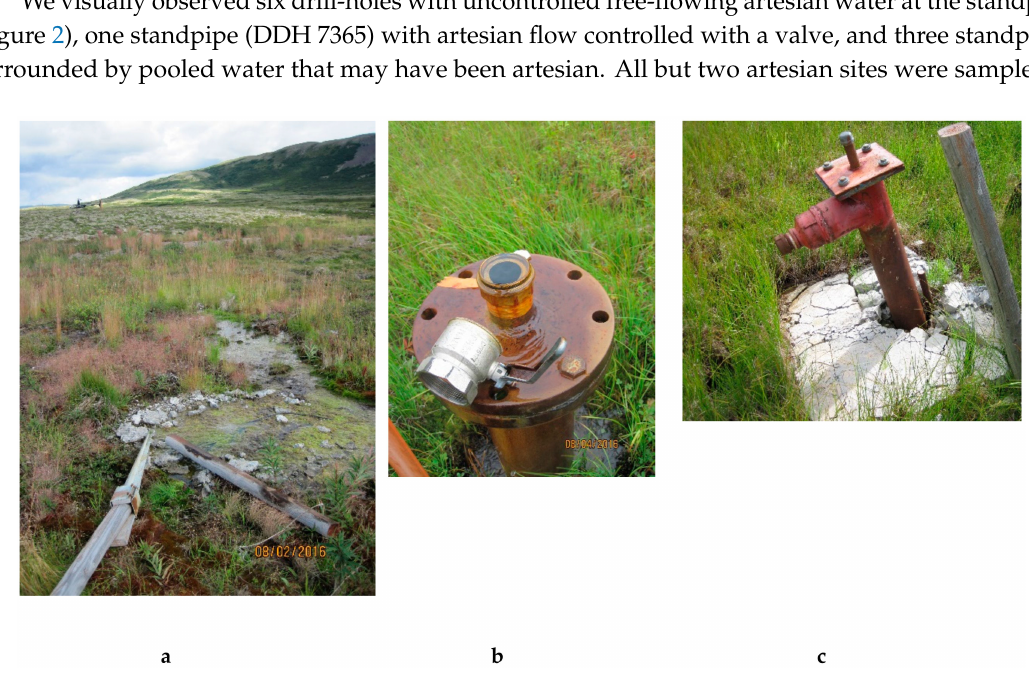
Figure 2. Artesian sites. Drilling was conducted in 2007–2008. ( a ) Artesian flow where drilling occurred at DDH 7386. ( b ) Artesian flow from a drill stem with a broken valve at DDH 7379. ( c ) Modified drill stem with no flow observed at DDH